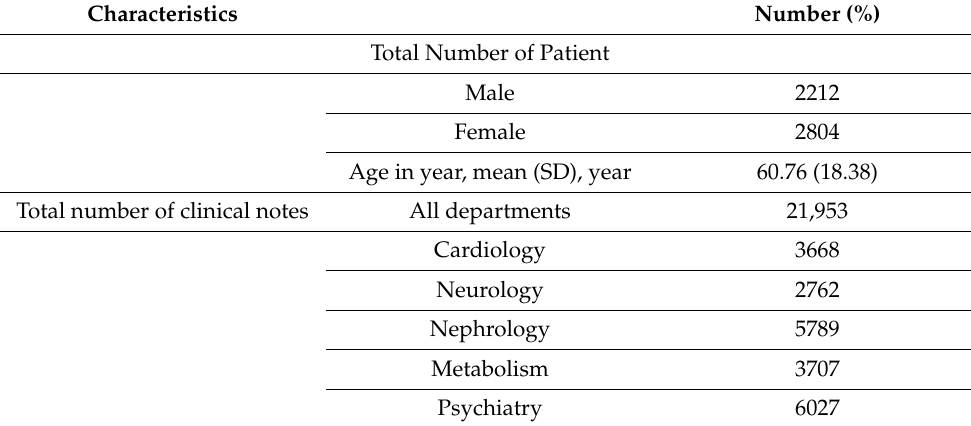
Table 1. Patient characteristic.